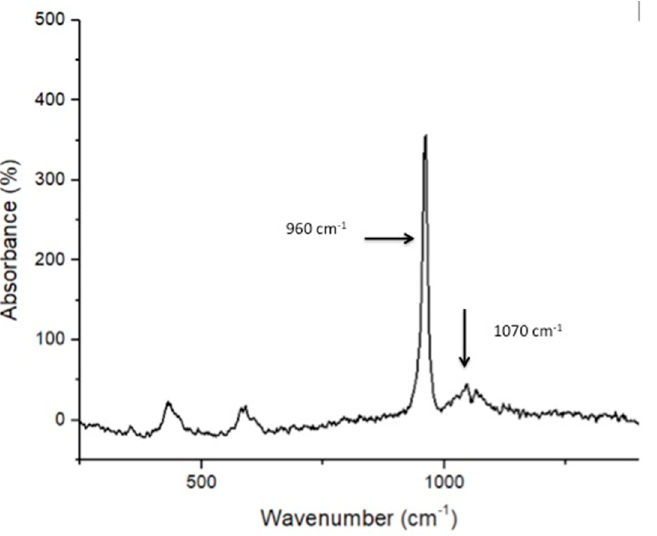
Figure 4. Raman spectra of the HA nanoparticles showing chemical groups identified by Raman analysis that could be identified as phosphate ( υ 1 PO4 ≈ 960 cm − 1 ) and carbonate group at 1070 cm − 1 .